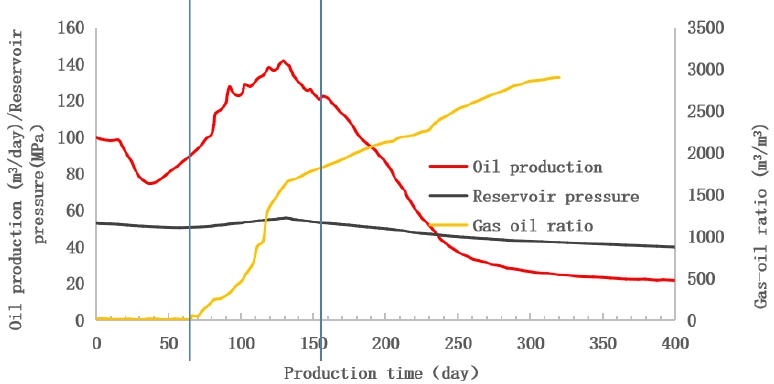
Figure 2. Prediction curve of oil production and gas-oil ratio of production well. Figure 2. P rediction curve of oil production and gas ‐ oil ratio of production well.